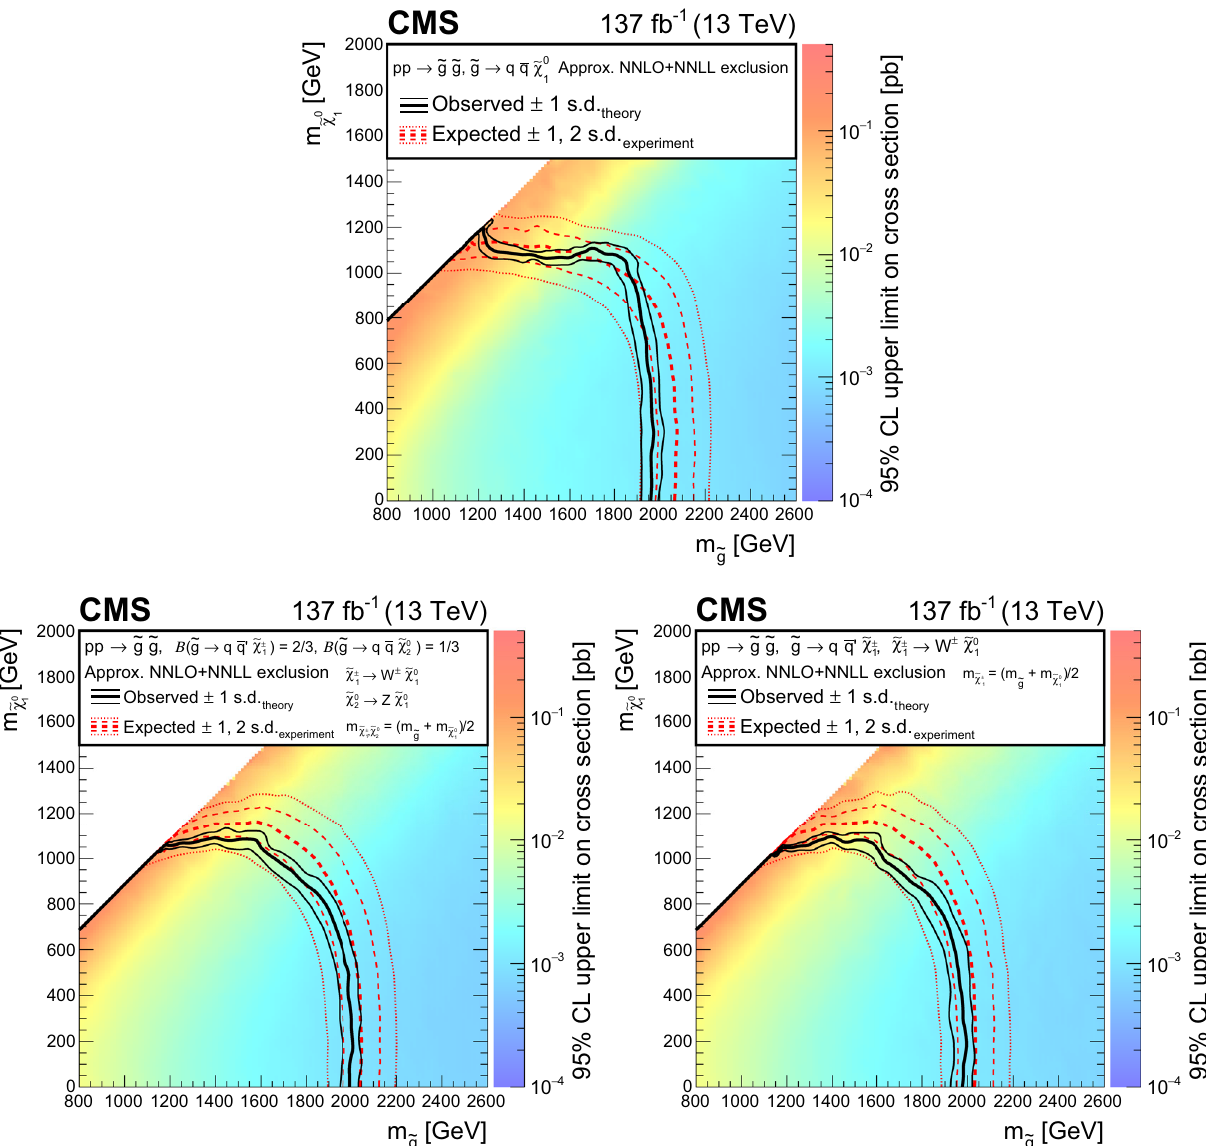
Fig. 11 Exclusion limits at 95% CL for direct gluino pair production, the dashed red lines indicate the expected limits and their ± 1 and ± 2 → Z ˜ χ 0 standard deviation (s.d.) ranges. The thin black lines show the effect where (upper) ˜ g → q ¯ q ˜ χ 0 , (lower left) ˜ g → q ¯ q ˜ χ 0 and ˜ χ 0 , 1 2 2 1 → W ± ˜ χ 0 of the theoretical uncertainties in the signal cross section. Signal cross or ˜ g → q ¯ q (cid:9) ˜ χ ± and ˜ χ ± , and (lower right) ˜ g → q ¯ q (cid:9) ˜ χ ± and 1 1 1 1 sections are calculated at approximately NNLO+NNLL order in α S → W ± ˜ χ 0 ˜ χ ± (with q = u, d, s, or c). For the scenarios where the 1 1 [136–147], assuming 1/3 branching fraction ( B ) for each decay mode gluinos decay via an intermediate ˜ χ 0 or ˜ χ ± , ˜ χ 0 and ˜ χ ± are assumed to 1 1 2 2 in the mixed-decay scenarios, or unity branching fraction for the indi- = 0 . 5 ( m ˜ + m ) . The area enclosed be mass-degenerate, with m ˜ χ ± ˜ χ 0 , ˜ χ 0 g cated 1 1 2 by the thick black curve represents the observed exclusion region, while